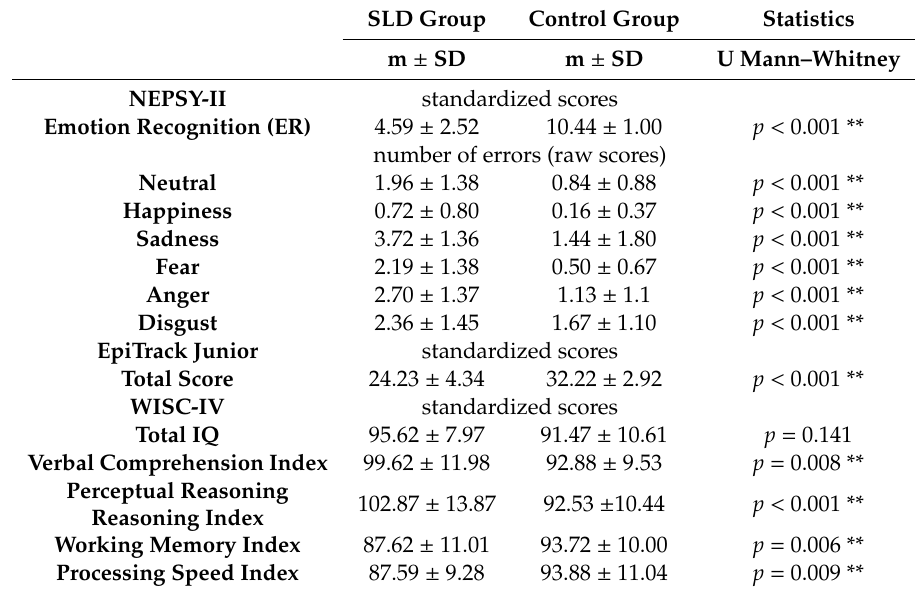
Table 2. Neuropsychological assessment in the SLD group and control group. SLD = Specific